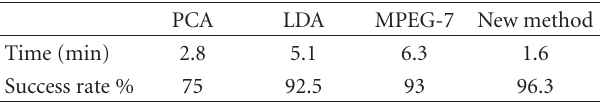
Table 14: The time consumed (in minutes) and the success recognition rate for the di ff erent methods using the Yale